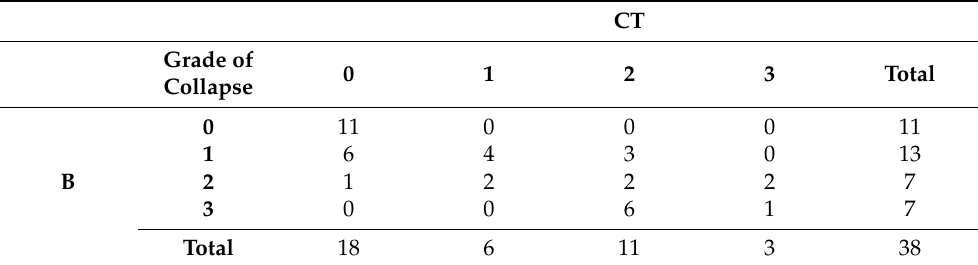
Table 7. Scoring of airway caliber narrowing of segmental/subsegmental bronchi using inspira- tory/expiratory breath-hold CT and bronchoscopic scoring. Reduction in airway calibers of segmental and subsegmental bronchi were scored using bronchoscopy as follows (modified from [6]: 0–25%, score = 0; 26–50%, score = 1; 51–75%, score = 2; >75%, score = 3.